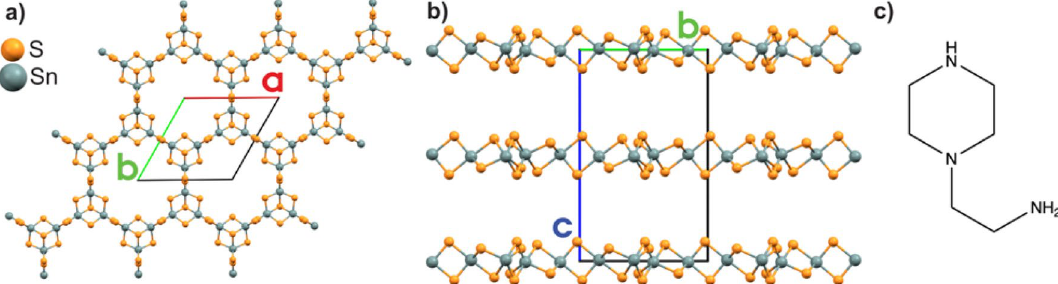
Figure 1. ( a ) Top view of the AEPz-SnS-1 structure with regular hexagonal pores, and ( b ) Side view of ABAB stacking layers of AEPz-SnS-1. ( c ) Molecular structure of AEPz used as structure directing agent and